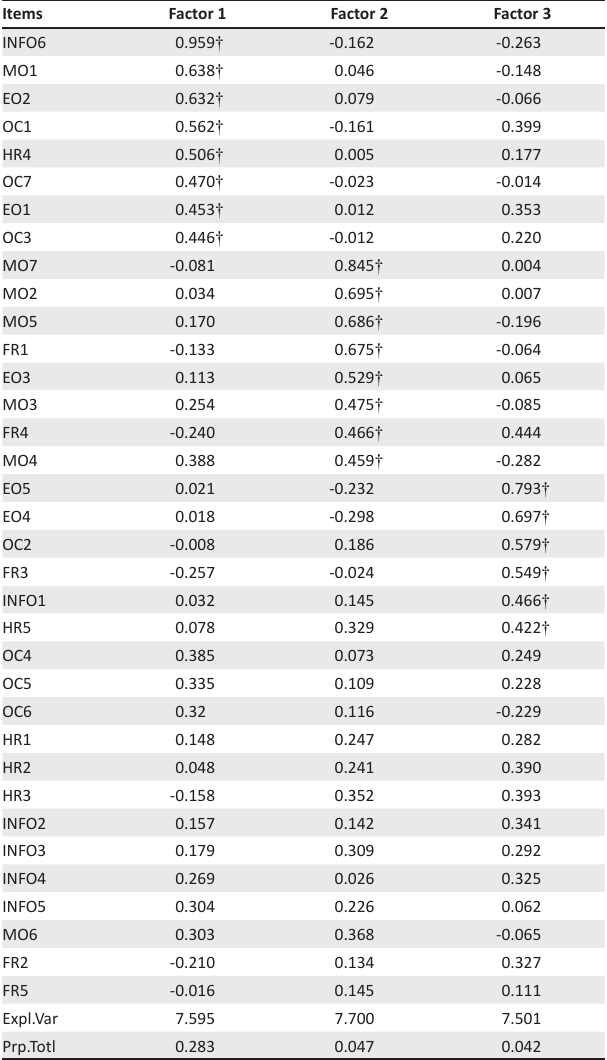
TABLE 2 : Factor structure of the independent variables.